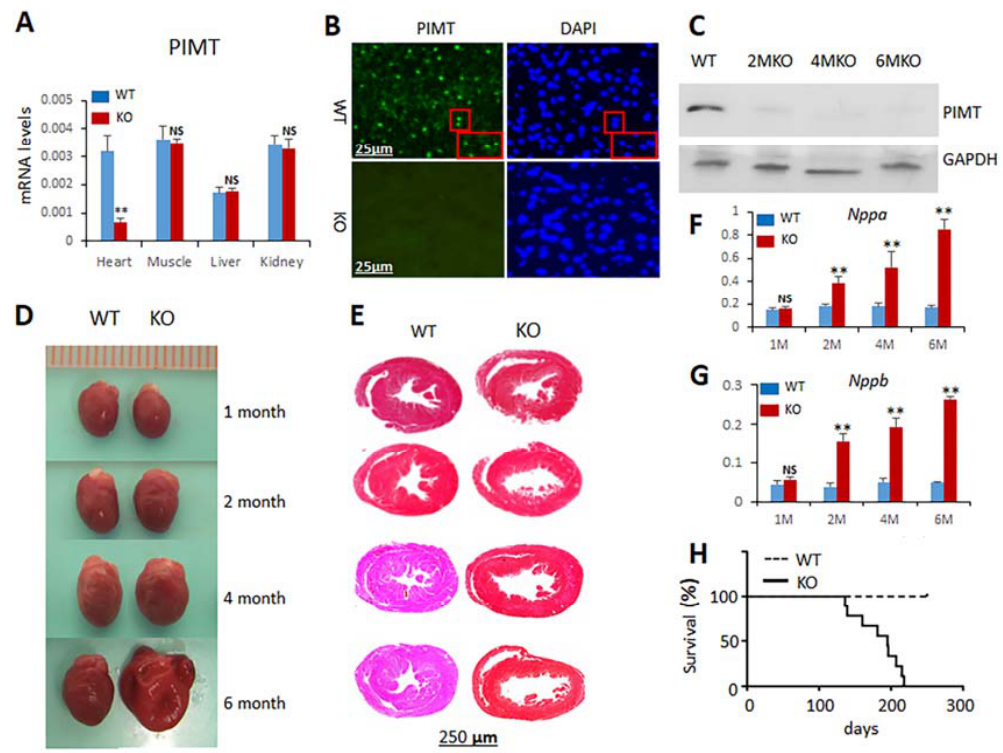
Figure 1. Cardiac-specific ablation of PIMT expression causes dilated cardiomyopathy. ( A ) Quantification of PIMT mRNA relative to 18S ribosomal RNA by RT-qPCR in PIMT fl/fl (WT) and csPIMT − / − (KO) mouse heart, muscle, liver and kidney; ( B ) Immunohistochemical localization of PIMT in 2-month-old PIMT fl/fl (WT) and csPIMT − / − (KO) mouse hearts. Nuclear localization of PIMT is evident in WT but not in KO hearts; compare DAPI stained images shown in right; ( C ) Western blot analysis for detecting PIMT protein level in PIMT fl/fl and csPIMT − / − mouse heart homogenates; ( D ) Representative photographs of heart of 1-, 2-, 4-, and 6-month-old csPIMT − / − mice and their PIMT fl/fl littermate controls. Six-month-old csPIMT − / − mouse hearts were flaccid and flabby; ( E ) Cross sections of hearts shown in Figure 1D were stained with H&E to reveal thinning of ventricular walls and dilation of chambers in csPIMT − / − mouse hearts (right panel); ( F , G ) Nppa and Nppb mRNA levels, respectively, in PIMT fl/fl and csPIMT − / − mouse hearts obtained at indicated ages. Each group was analyzed using 5 different mice (each mouse was assayed separately) and the values were expressed as the mean ± SD. * p < 0.05, ** p < 0.01, NS: not significant; ( H ) Survival curve showing lethality of mice with csPIMT − / − hearts. 36 mice for each group of PIMT fl/fl and csPIMT − / − were used for the generation of survival curve. Kaplan-Meier method was used to determine the survival rates and data were compared using log rank test. Each group was analyzed using 5 different mice and the values were expressed as the mean ± SD. * p < 0.05, ** p < 0.01, NS: not